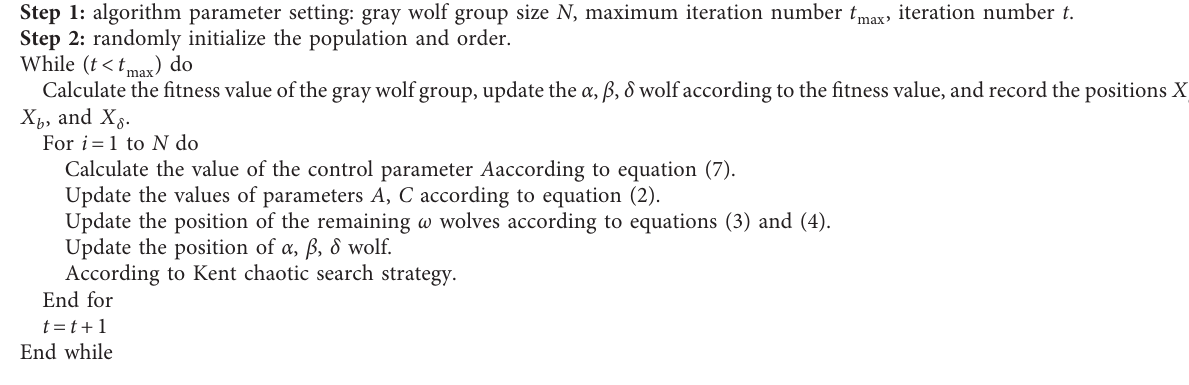
A LGORITHM 1: CNGWO algorithm flow (CNGWO algorithm